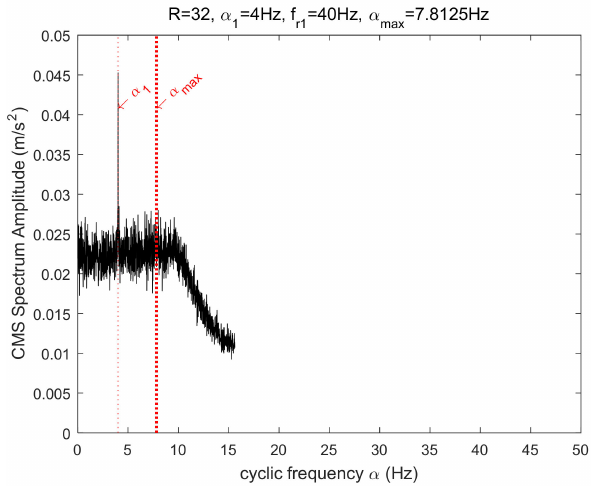
Figure 2. Vibratio n spectrum analyzed by cyclic modulation spectrum (CMS) with R =